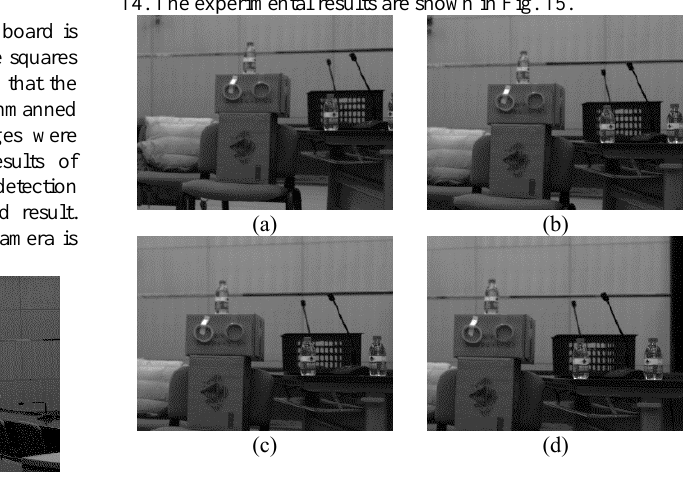
Fig. 11 The translation error and run time of four methods.